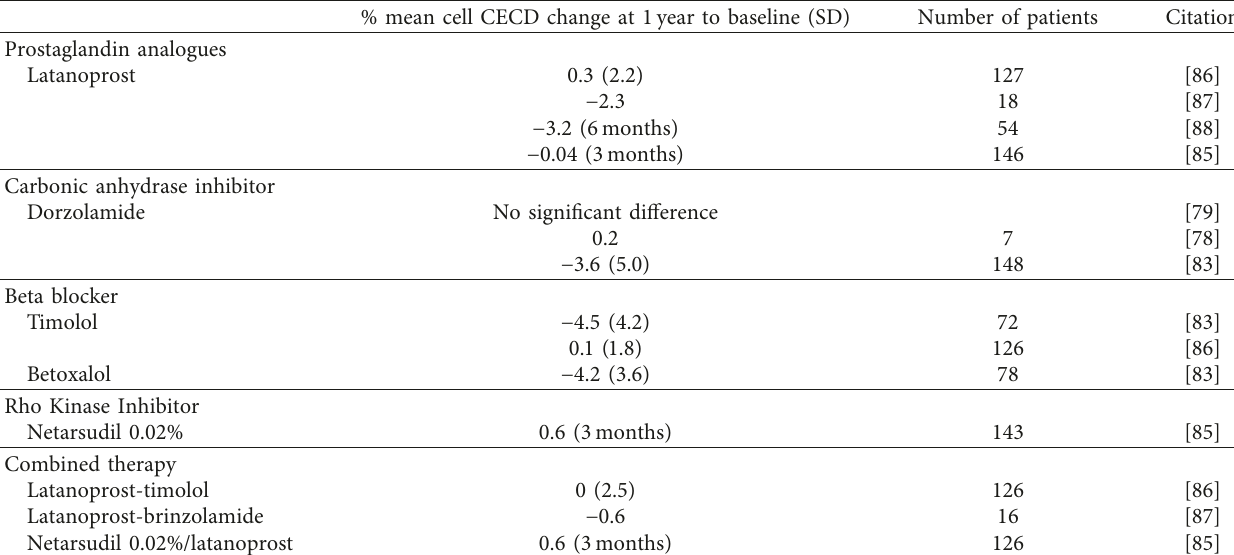
Table 2: Effect of topical medication on corneal endothelial cell density